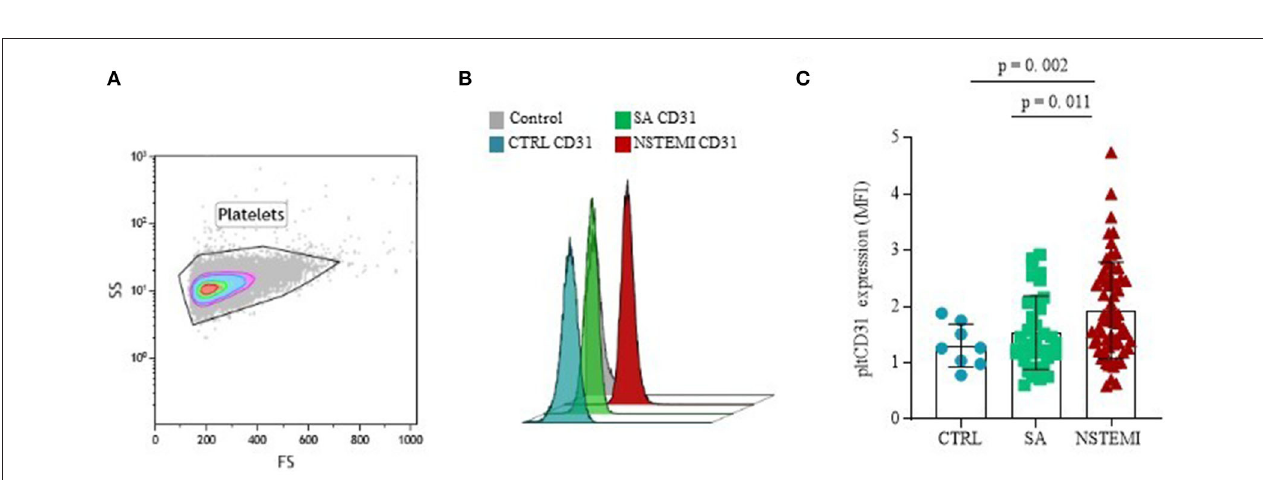
( n = 11; Mean ± SD: 39.04 ± 10.04) ( p = 0.064) ( Figure 4A